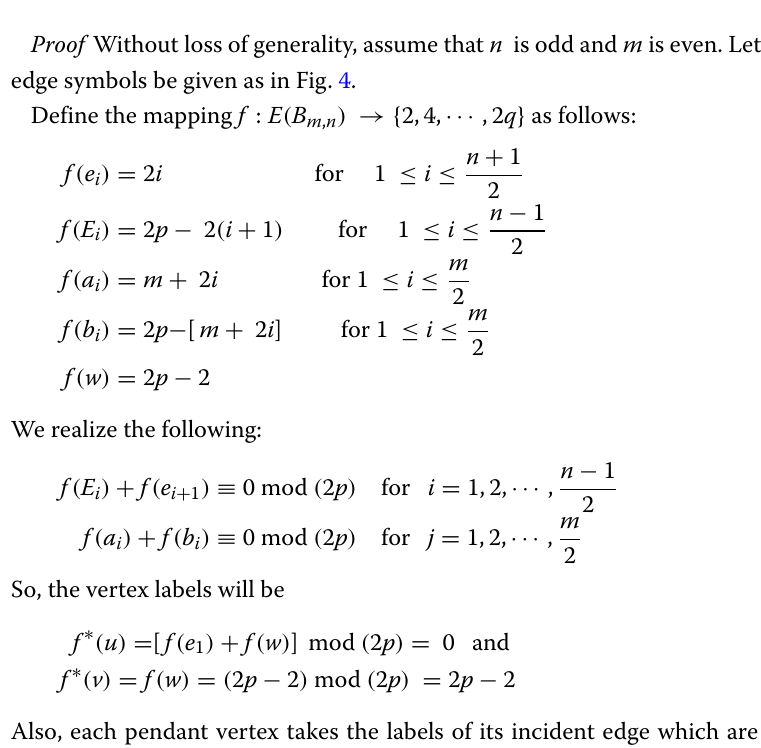
Fig. 3 The edge even labeling of the graph Y 13